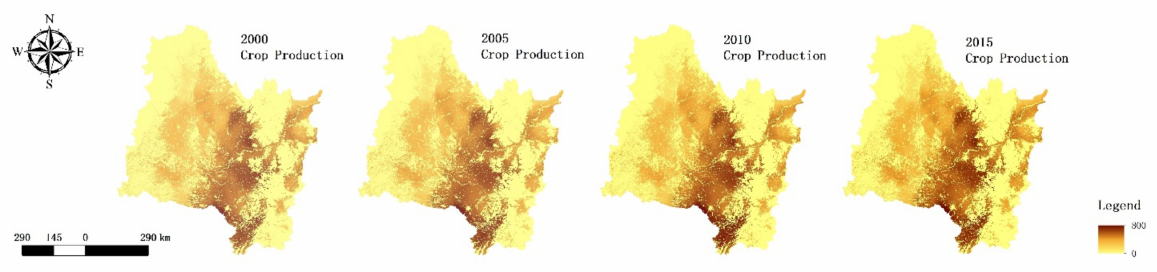
Figure 7. Distribution map of crop